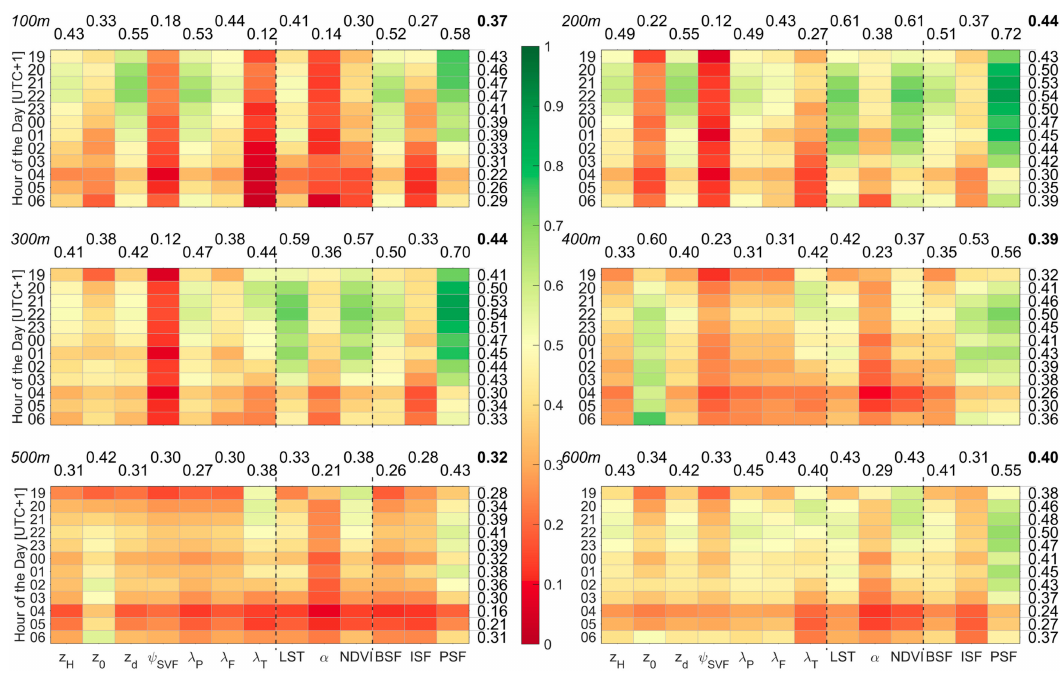
Figure 2. Correlation coefficients of all linear regressions for the 100 to 600 m cell size runs as a suitability test. The columns represent the individual predictors and the rows represent the different time of the day, colored after the specific correlation coefficient (red = 0 to green = 1). The three different groups are separated by vertical dotted lines and the abbreviations are mentioned in the